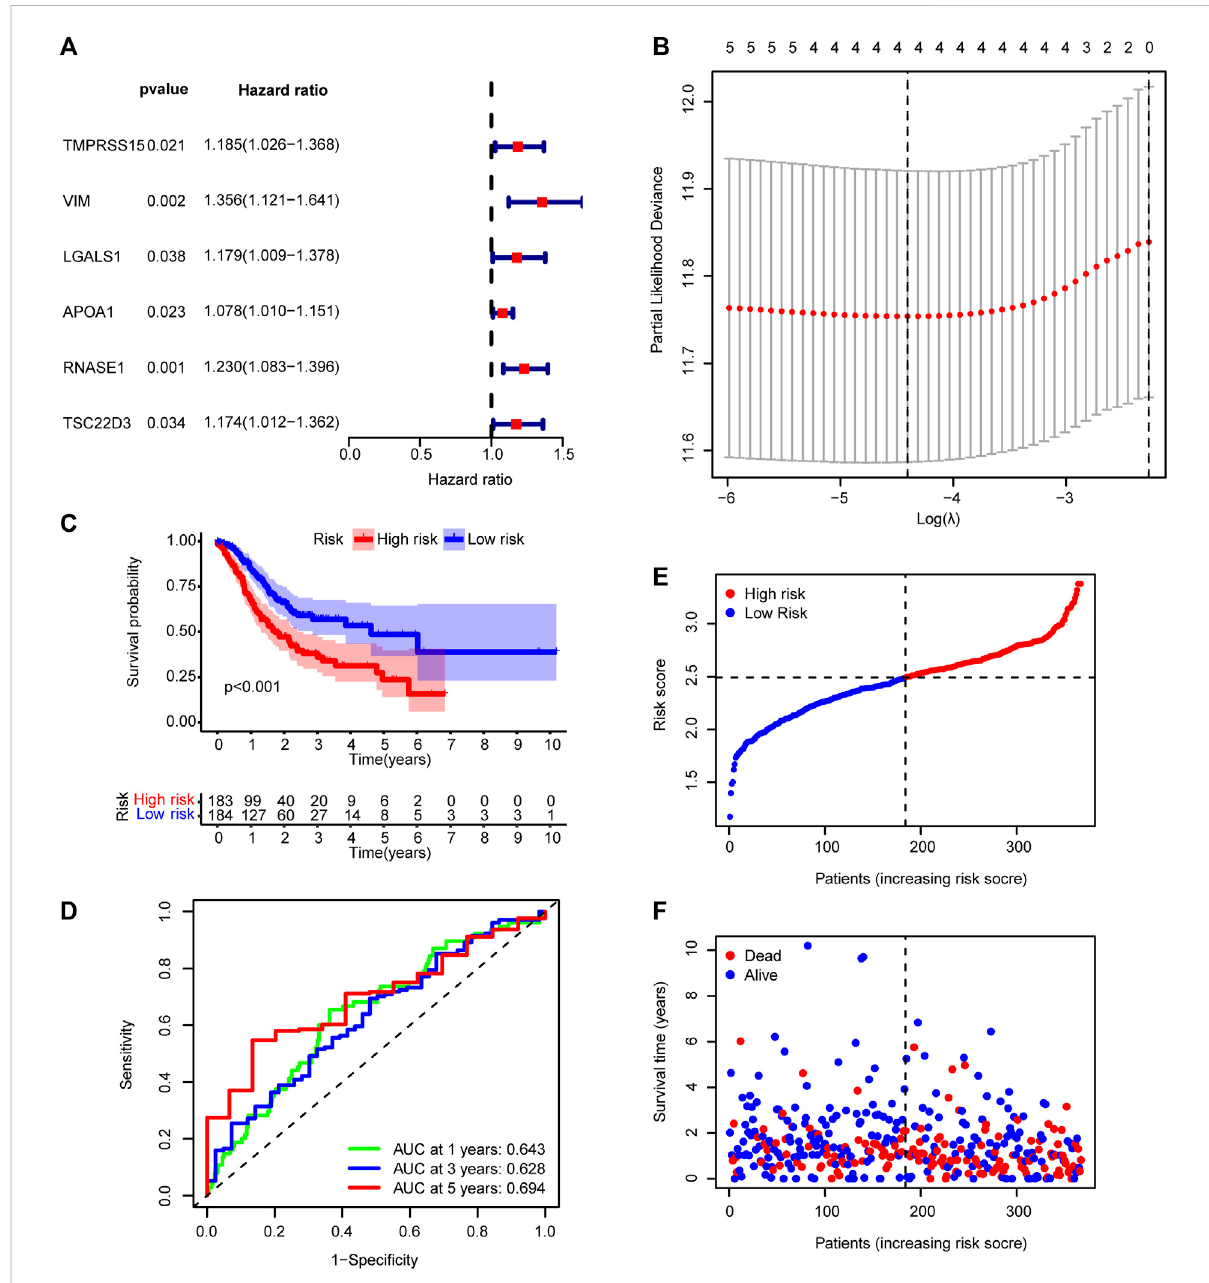
FIGURE 5 Prognosticmodelbased ondifferentially expressed genesbetweentheearlygastric cancer and intestinal metaplasiagroups. (A) Univariate Cox regression analysis showing the correlation between six genes and disease prognosis. (B) Diagram of error rates by 10-fold cross-validation. (C) Kaplan – Meier survival analysis for the high- and low-risk groups in TCGA cohort. (D) Time-dependent ROC curves showing the predictive accuracy of the prognostic model in TCGA cohort. (E) Risk score distribution and (F) survival status for patients in the TCGA dataset. AUC, area under the